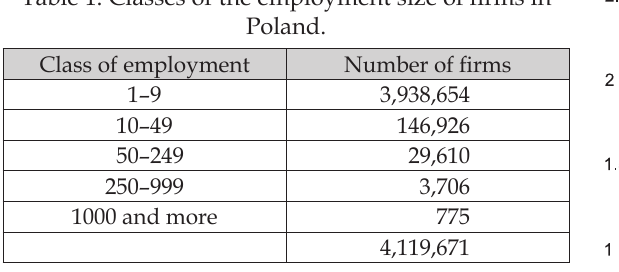
Table 1. Classes of the employment size of firms